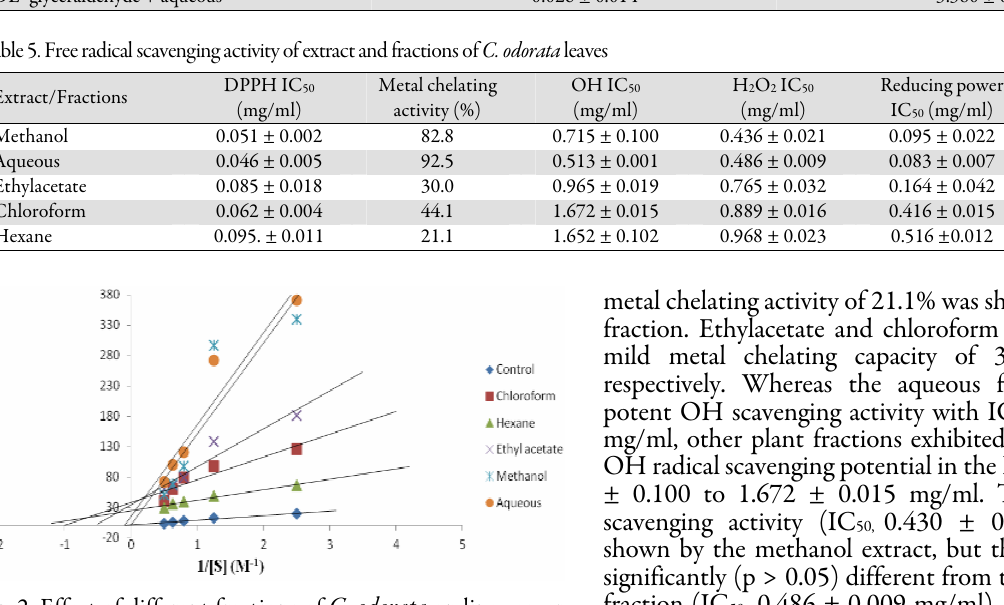
Fig. 2. Effect of different fractions of C. odorata on lineweaver- Burk plot of aldose reductase